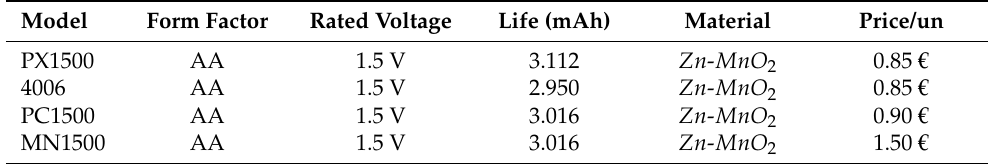
Table 3. Initial list of alkaline